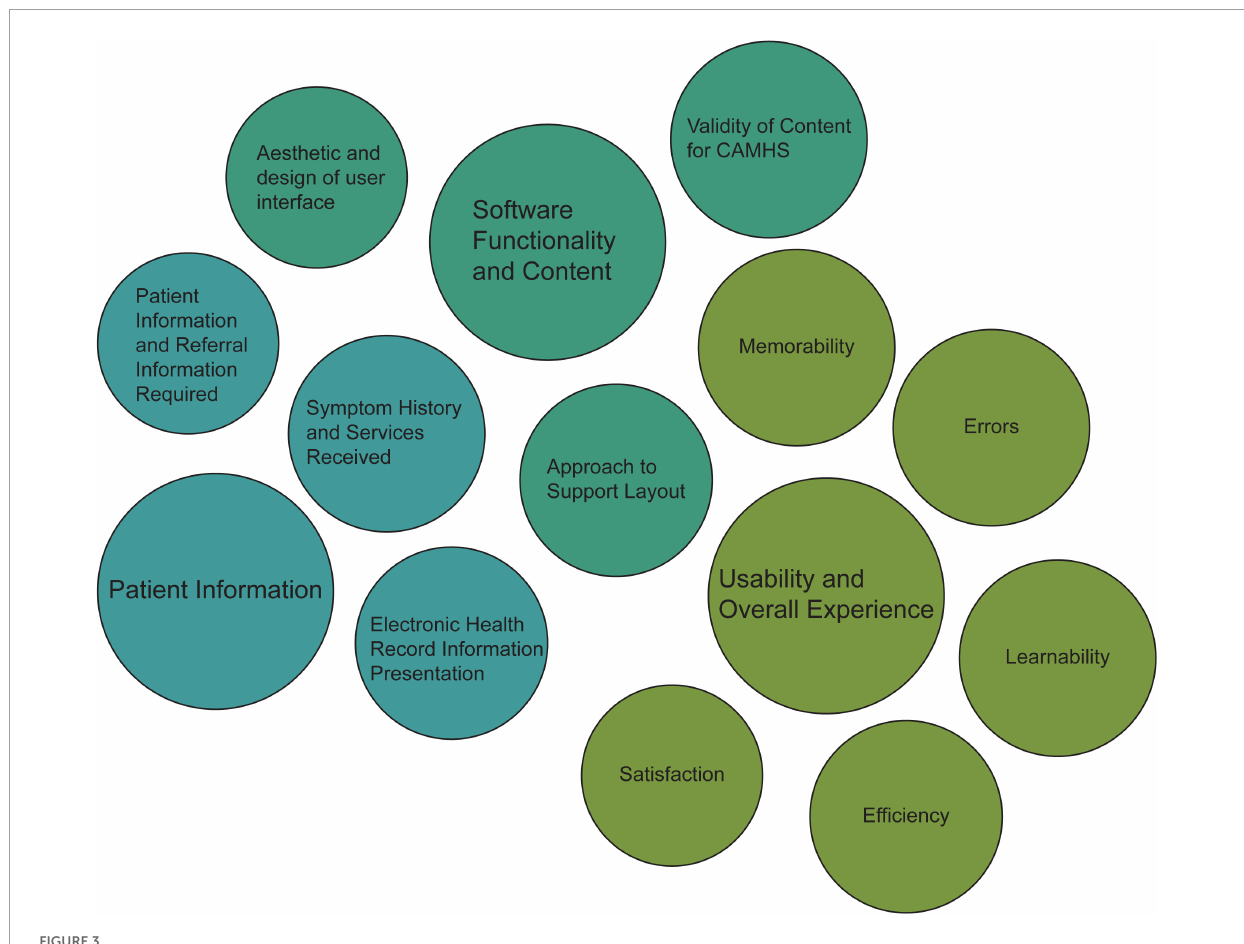
FIGURE3 Qualitative content analysis applied main categories and